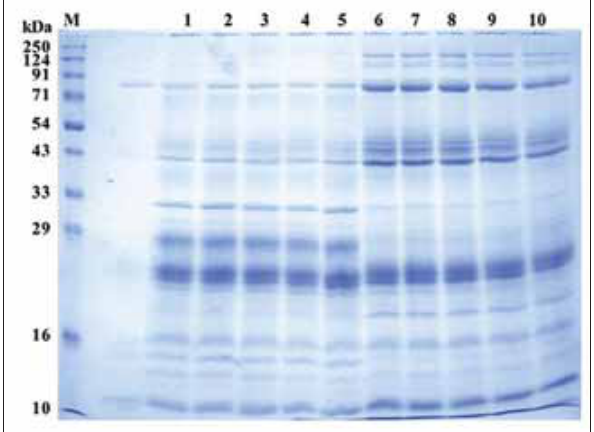
Figure-1: Sodium dodecyl sulfate polyacrylamide gel electrophoresis (SD-PAGE) of heparin binding proteins (HBPs) of buffalo bull 605 and 790. Lane M: Marker; Lane 1,2,3,4 and 5: HBPs of bull number 605; Lane 6,7,8,9 and 10: HBPs of bull number